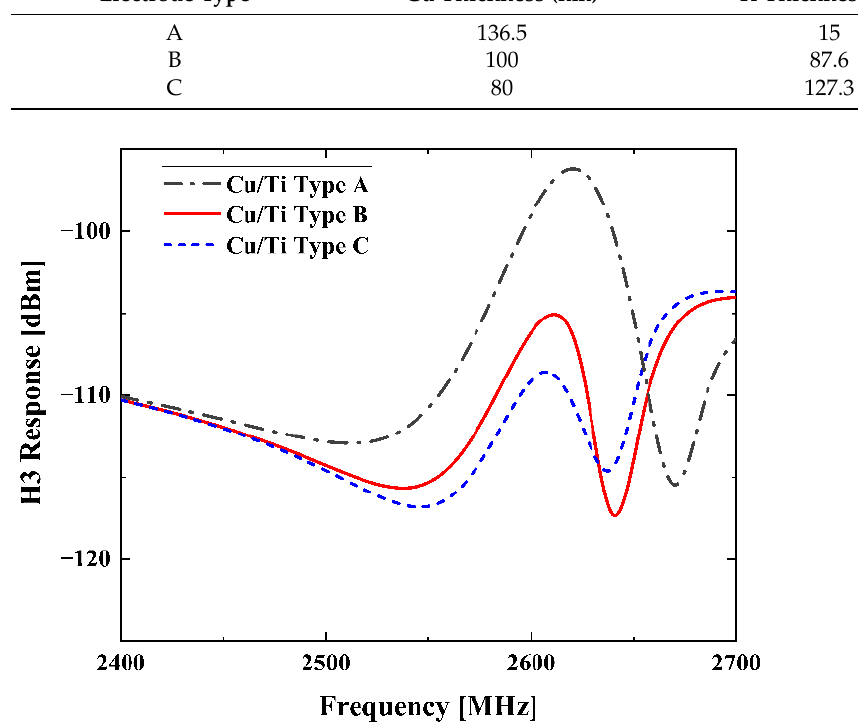
Figure 6. Simulated H3 responses of the SAW resonators in Table 1.